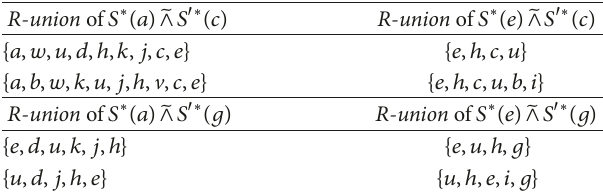
Table 4: 𝑅 -union on 𝐴∧ 𝑋 𝐵 correlation table.